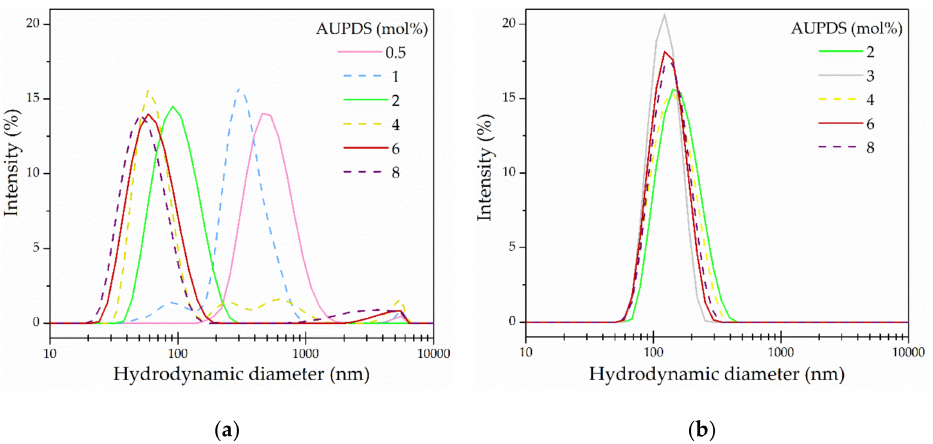
Figure 2. Hydrodynamic diameter distribution curves in terms of intensity (%) obtained via DLS analysis of ( a ) PS- co -AUPDS NPs and ( b ) PMMA- co -AUPDS NPs formulated using different amounts of AUPDS (in mol% relative to the dispersed